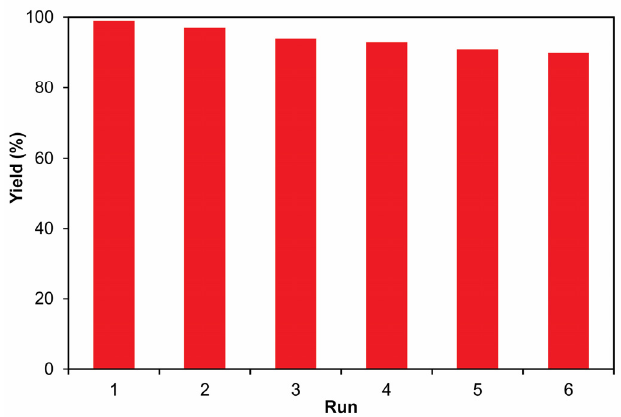
Figure 8. The recycling of the Pd-Fe 3 O 4 -CWH